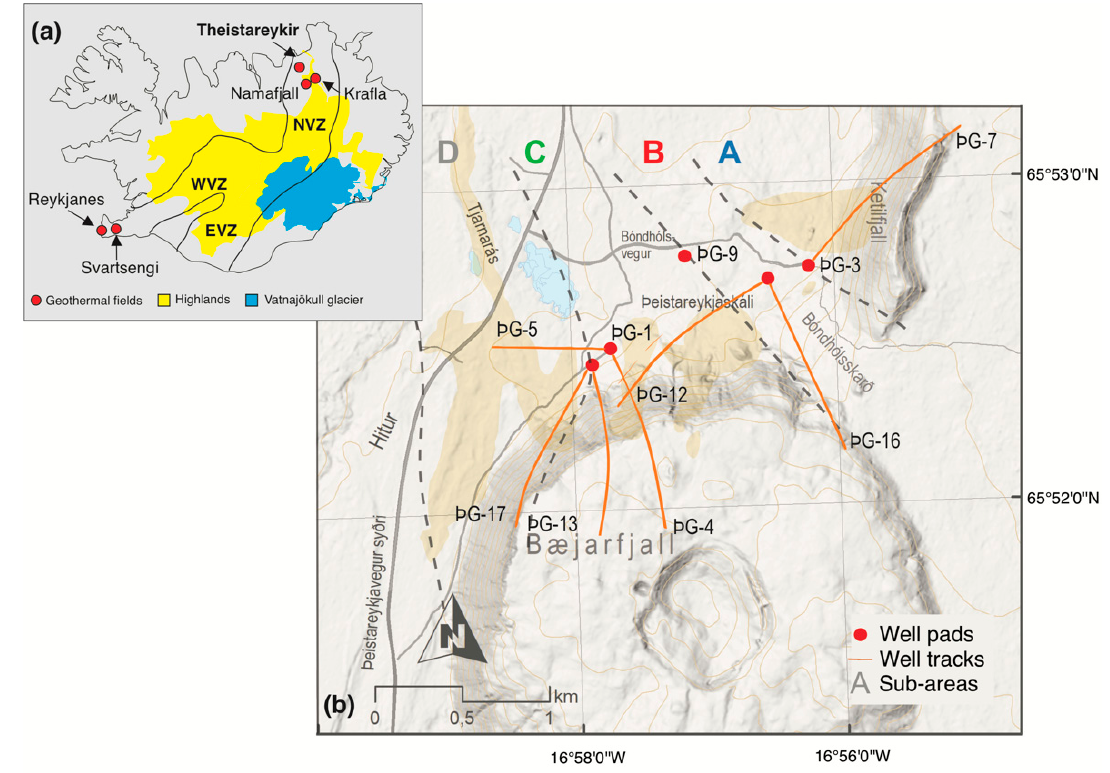
Figure 1. ( a ) Iceland, with the locations of the main geothermal sites cited in the text, and the location of the Iceland Highlands with major glaciers. Abbreviations: NVZ = Northern Volcanic Zone; WVZ: Western Volcanic Zone; EWZ = Eastern Volcanic Zone. ( b ) Detailed map of the production area of the Theistareykir geothermal field, with the sampled wells and the subareas defined by